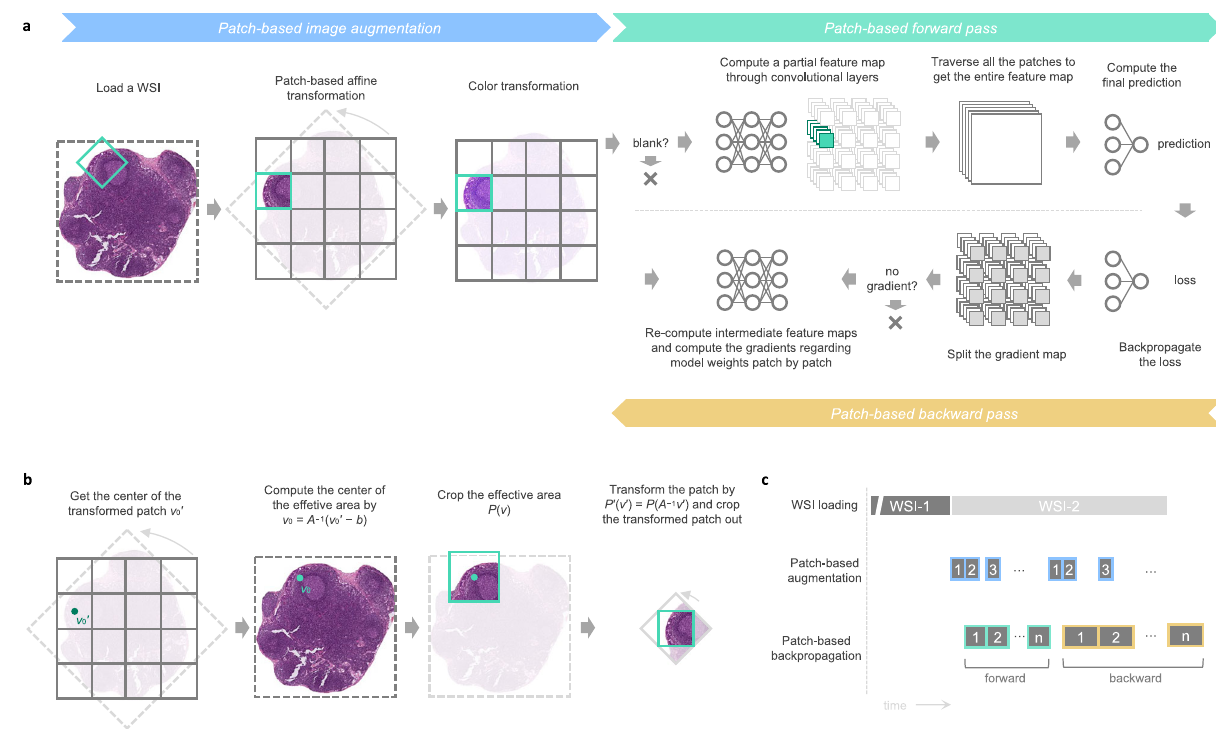
Fig. 7 ESCNN as a weakly supervised method for training gigapixel images. a Data fl ow of ESCNN illustrates how patching mechanisms are embedded into image augmentation and the backpropagation algorithm (including forward pass and backward pass). b Procedure of the patch-based af fi